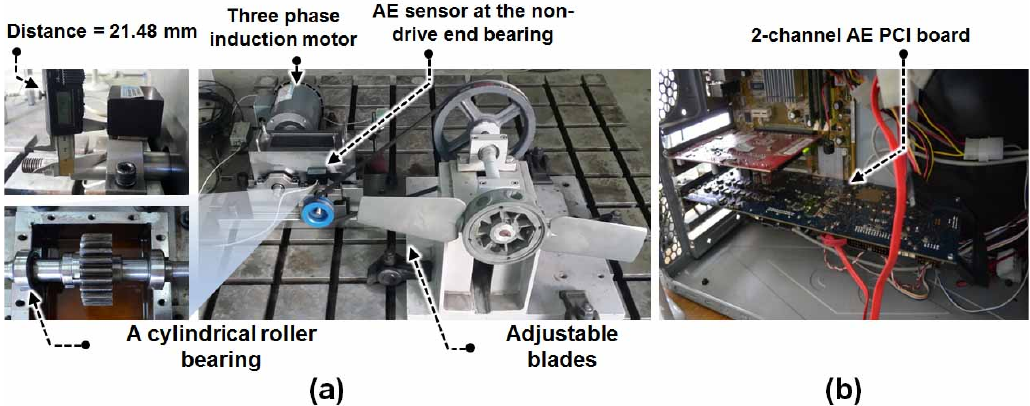
Figure 2. Cylindrical rolling element bearings, ( a ) parts of the bearing, ( b ) measurement of bearing.